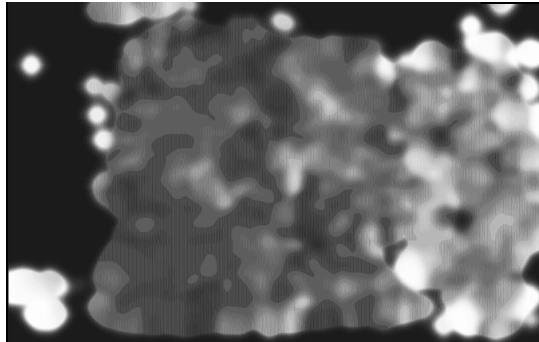
Figure 9. Image representing the module of residual generated for the internal calibration using the Fraser’s model.